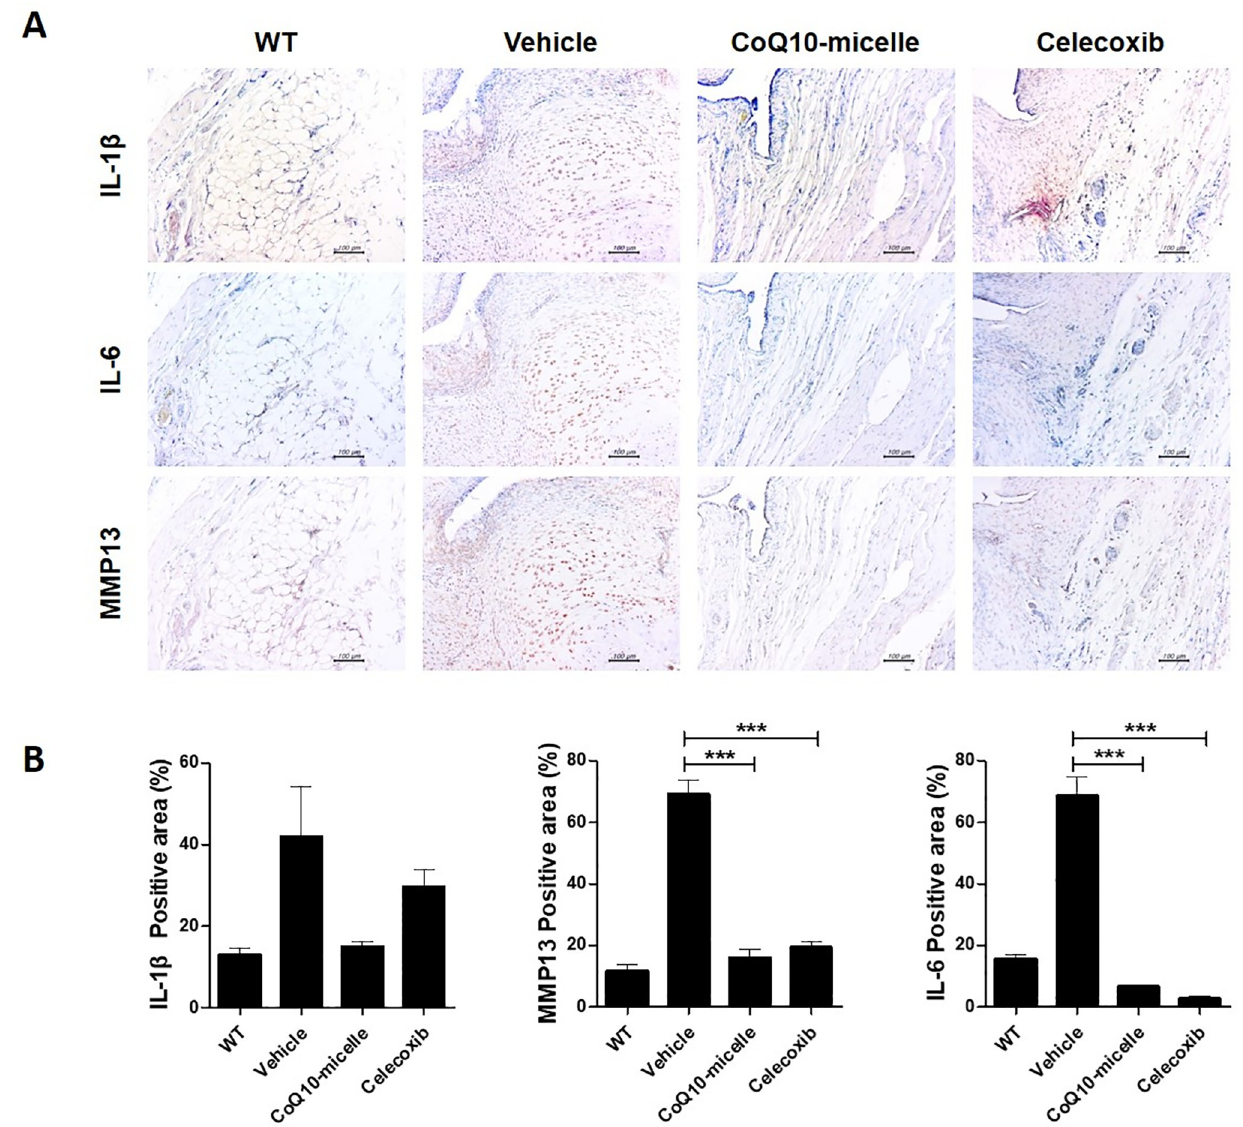
Fig 5. The anti-inflammatory effects of CoQ10-micelles during OA progression. (A) Representative images of immunohistochemical staining of IL-1 β , IL-6, and MMP13 in the joint synovia of a WT group, a vehicle group, a CoQ10-micelle group, and a celecoxib group. (B) The bar graphs show the average positive areal percentages for IL-1 β , IL-6, and MMP13. Data are shown as means ± S.E.Ms. Statistical significance was assessed using the Bonferroni test. � p <